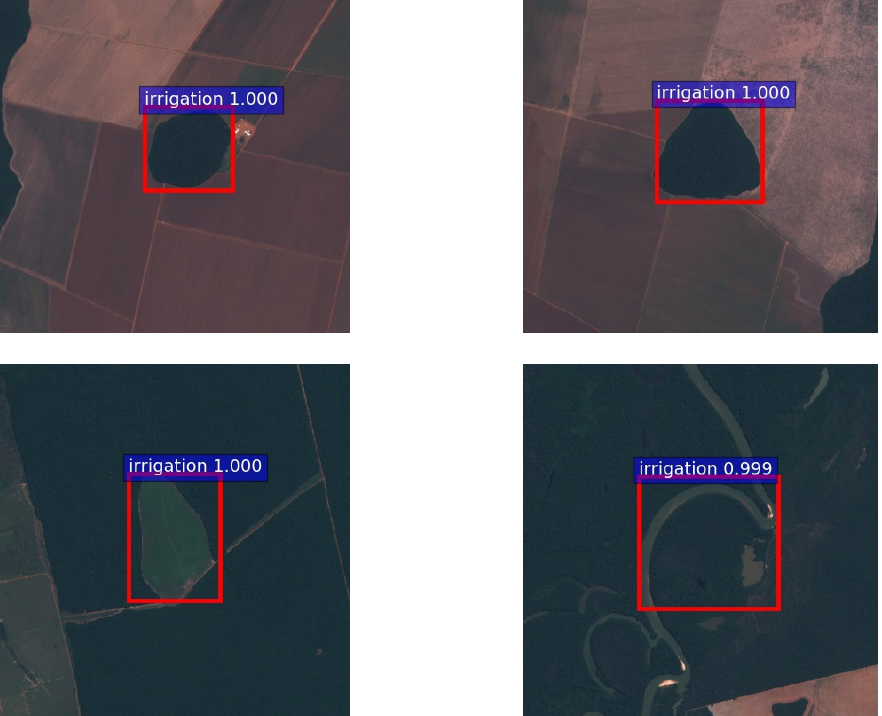
Figure 3. Examples of the false detections of